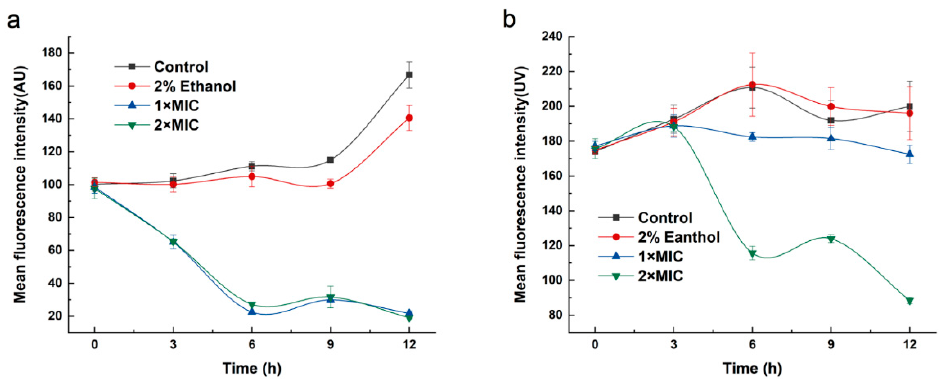
Figure 3. Effect of 3-carene on the fluorescein diacetate (FDA) fluorescence intensity of bacteria: ( a ) B. thermosphacta , ( b ) P. fluorescens .